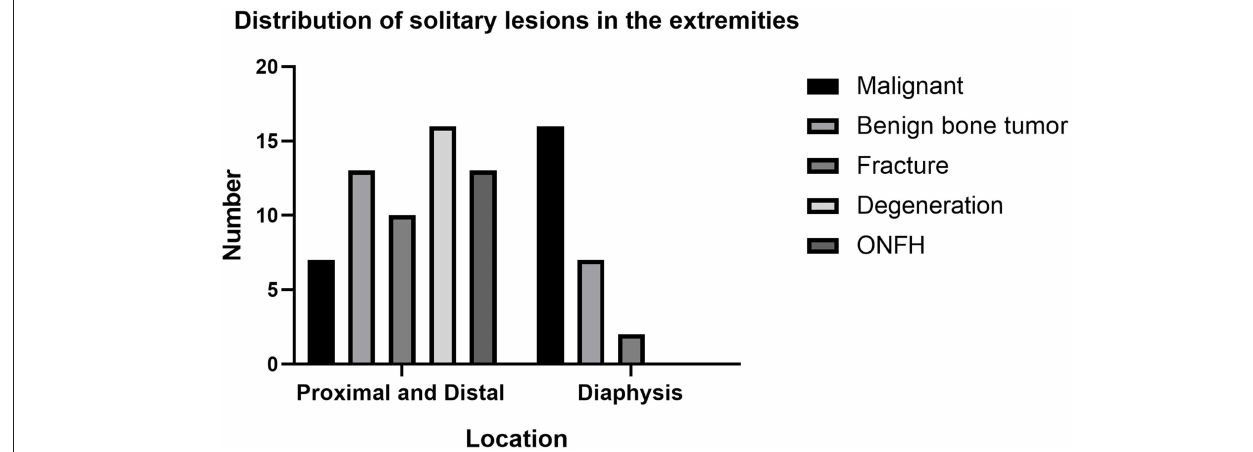
FIGURE 1 | Distribution of solitary lesions in the extremities.